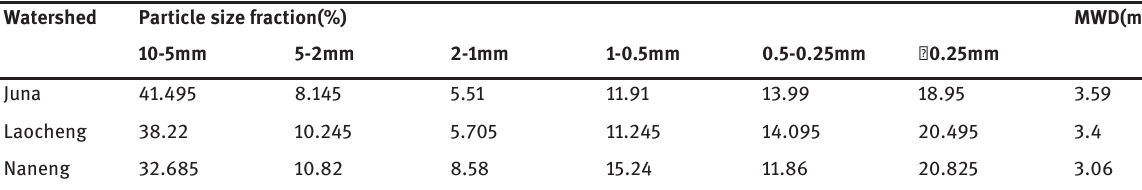
Table 5: Characteristics of soil wet sieve aggregates in watershed.